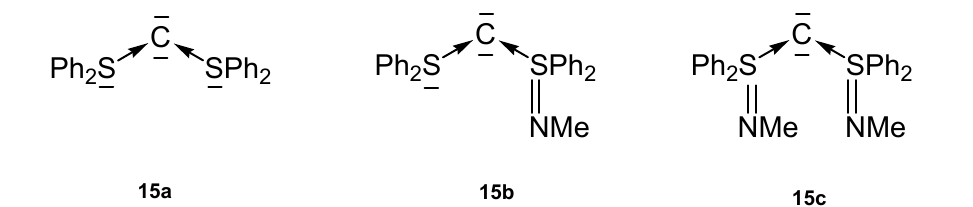
Figure 17. Mixed P and S stabilized carbone 14 .